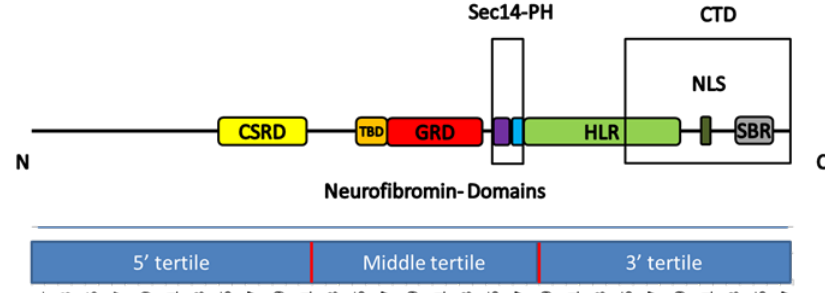
Figure 1. Schematic representation of the tertiles of the neurofibromatosis type 1 ( NF1 ) gene and the domains of neurofibromin. CSRD, cysteine / serine-rich domain; TBD, tubulin-binding domain; GRD, GTPase activating protein-related domain; PH, pleckstrin homology-like domain; Sec-14, Sec14-like domain; HLR, HEAT-like repeat regions; NLS, nuclear localisation signal region; CTD, C-terminal domain; SBR, syndecan-binding region.